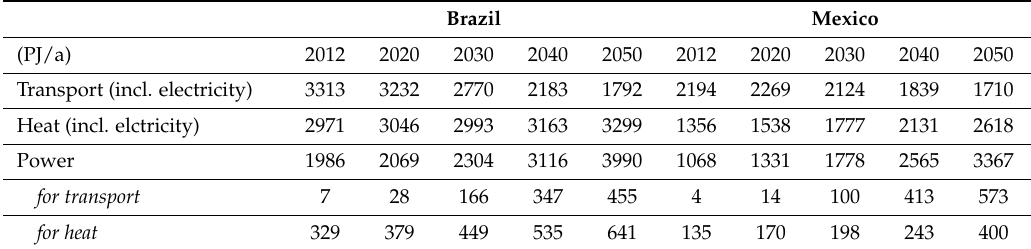
Table 6. Results for final energy demand in PJ/a by field of application in